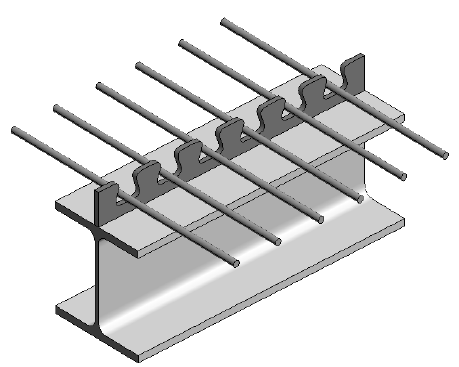
Figure 2. Composite beam with Crestbond shear connector